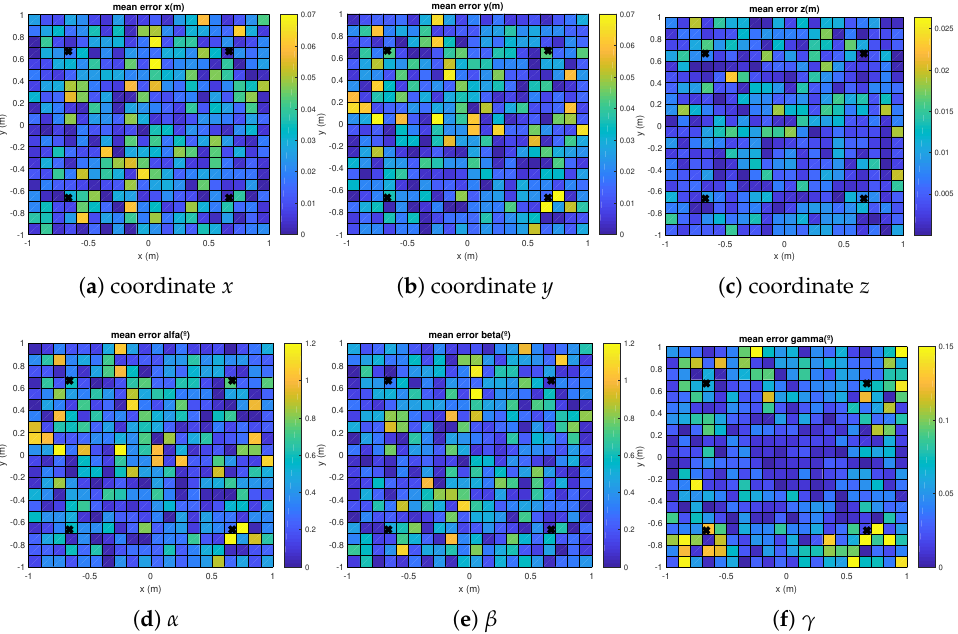
Figure 4. Mean absolute errors in the grid of considered points in the floor for the IPPE algorithm and a rotation in the Z axis γ = 120 ◦ .